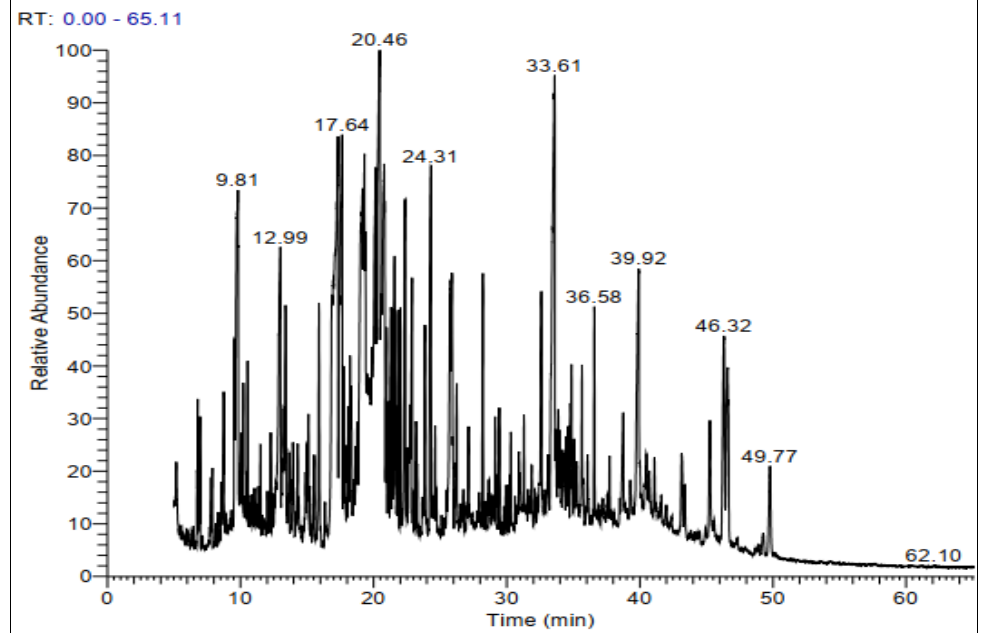
Figure 1. Representative GC-MS chromatogram of derivatized methanolic extract of C. mixtus flowers.